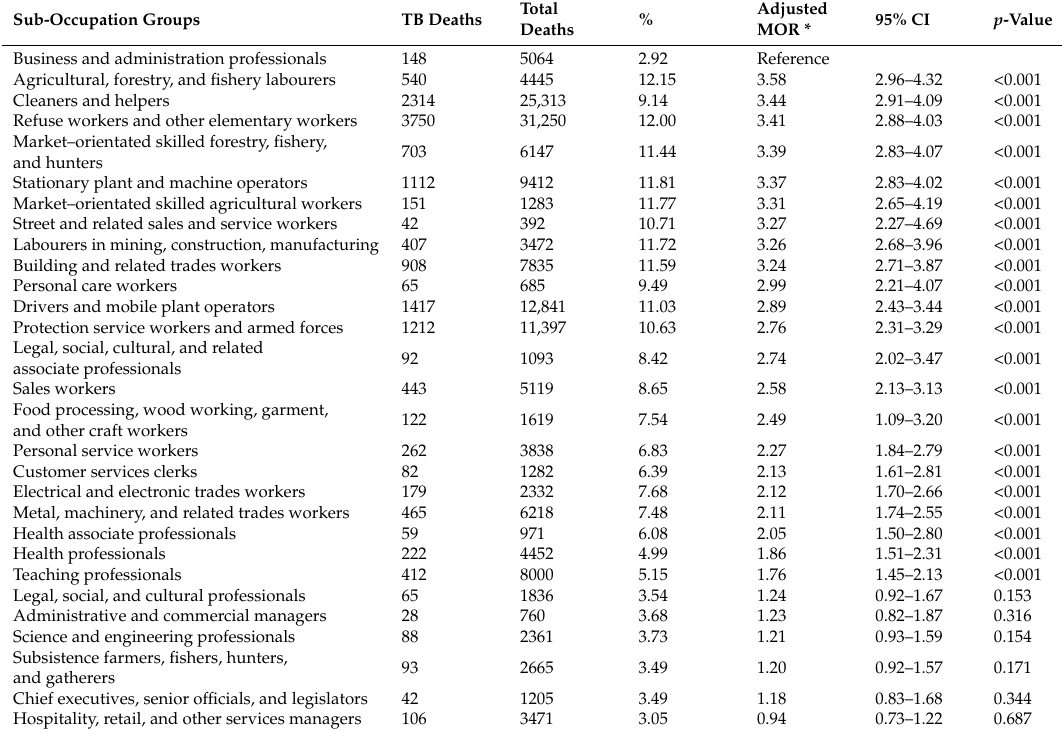
Table 2. Adjusted TB mortality odds ratios (MORs) by occupation sub-groups among persons aged 15–64 years in South Africa,